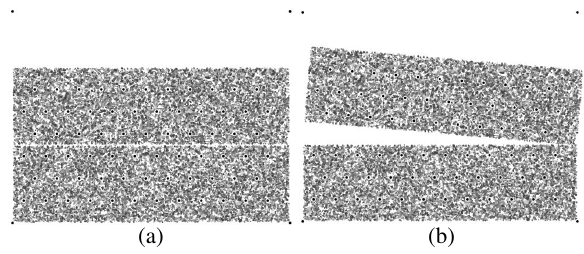
Figure 8. (a) Reference pattern generated with vector graphics; (b) deformed state with a known rotation of 5° of the upper part.